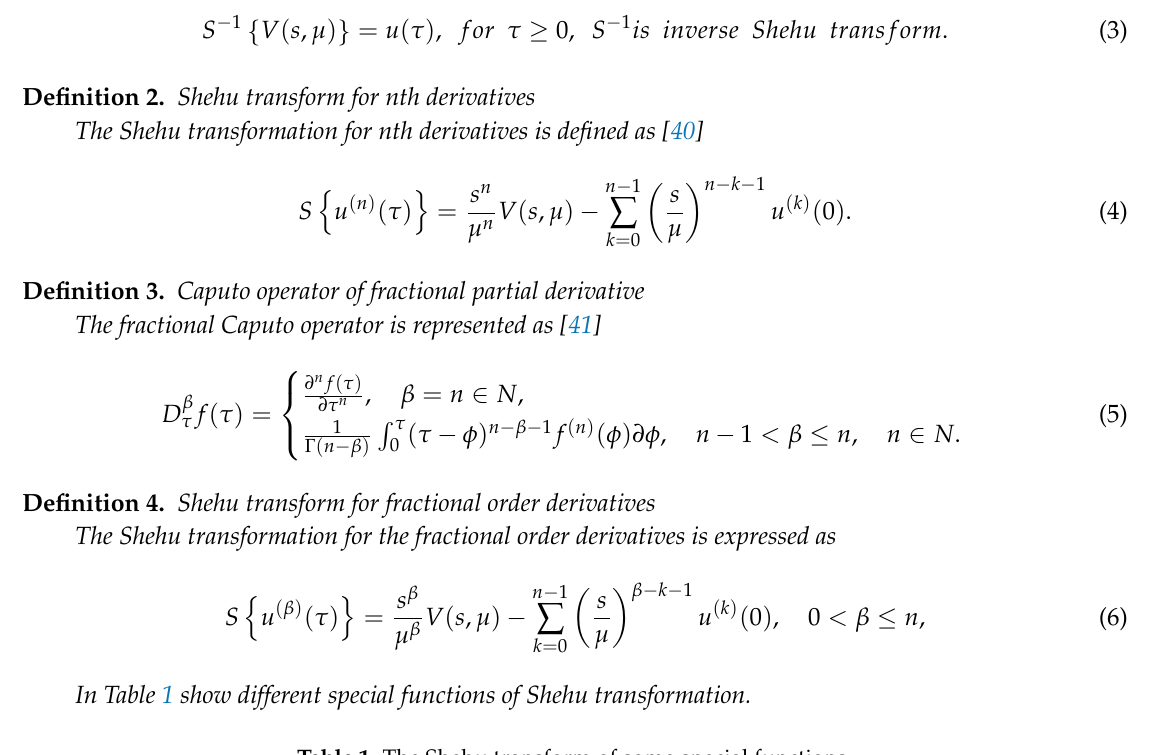
Table 1. The Shehu transform of some special functions. Functional